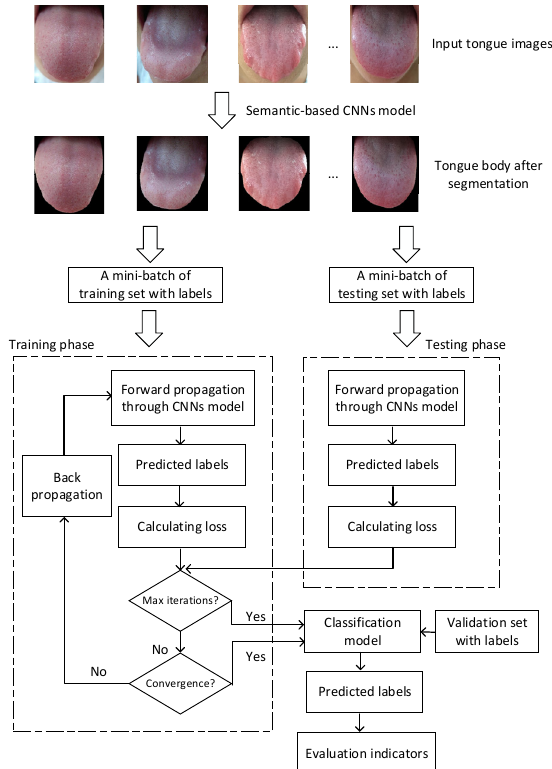
Figure 6. Procedures of training feature extraction models based on CNNs.